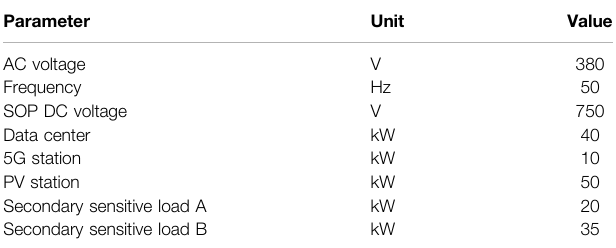
TABLE 1 | System parameters. Parameter